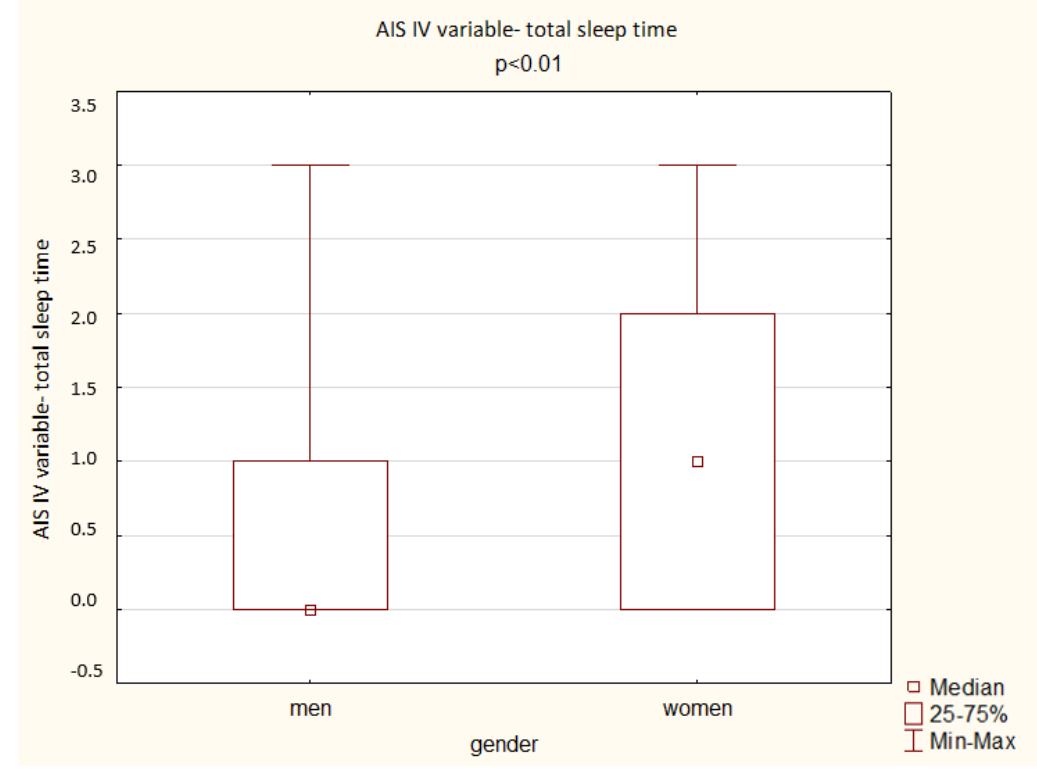
Int. J. Environ. Res. Public Health 2022 , 19 , x FOR PEER REVIEW Figure 3. Patient results in the AIS IV variable — total sleep time (Mann – Whitney U test). Figure 3. Patient results in the AIS IV variable—total sleep time (Mann–Whitney U test).